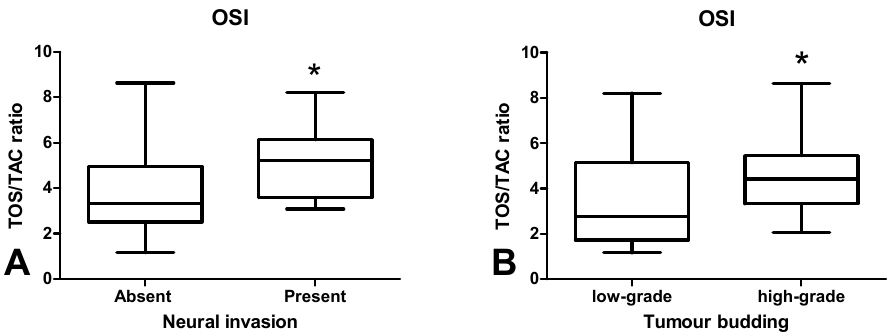
Figure 7. Comparison of OSI value between colorectal tissue with and without neural invasion ( A ) and between colorectal tissue with low-grade and high-grade budding ( B ). The data are presented as median (minimum–maximum). Abbreviations: OSI—oxidative stress index. * p < 0.05.